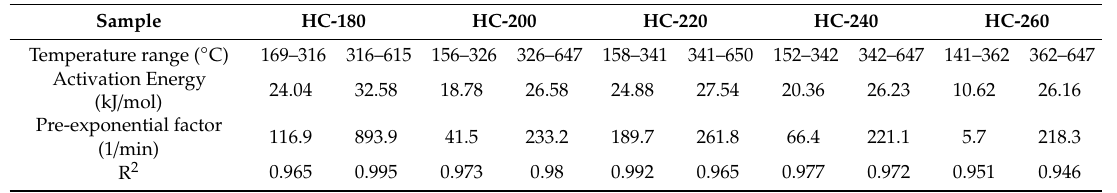
Table 6. Kinetic parameters of manure-derived